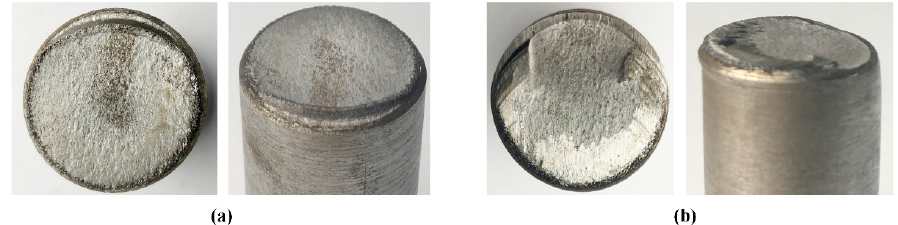
Figure 12. Macro-fractography for Test 3–4 with different axial clearance for 40Cr steels. ( a ) C 1 = 1 mm. ( b ) C 1 = 2 mm.